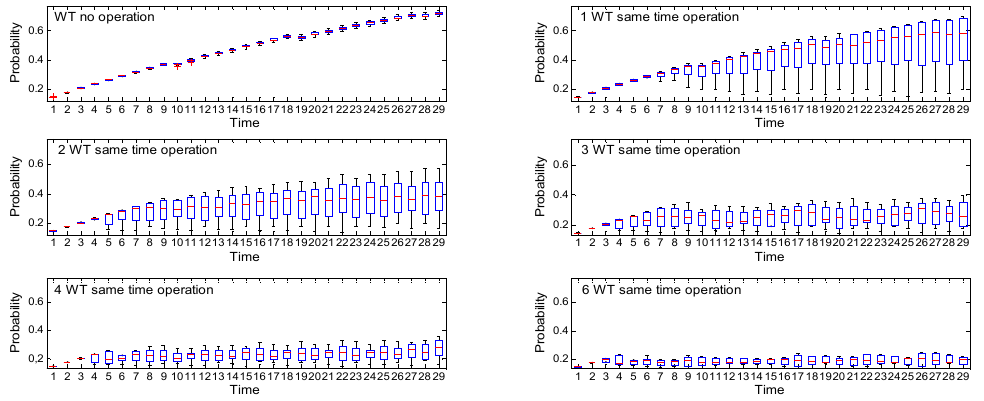
Figure 9. Boxplot of the fault probability of the offshore wind farm for WT operated at the same time. The maintenance task will be carried out when certain permission value is reached. This dimensionless value, which varies from 0 to 1, will be given by a weighting of the weather conditions and external permissions. It has been simulated in this paper and validated by experts. Figure 10 shows the maximum allowed value assigned to each event. The maximum allowed valued is randomly generated for this case. It is due to the goal of this study is to clarify how the proposed methodology should be applied, taking into account that the method is close to the reality only from the qualitative point of view. This value is compared with a predicted value given randomly in this paper in order to consider the stochastic of the system. If the value assigned to the task is bigger than the predicted value, the maintenance task must be carried out, in other case, it must be necessary to wait for a suitable value from the forecasting.